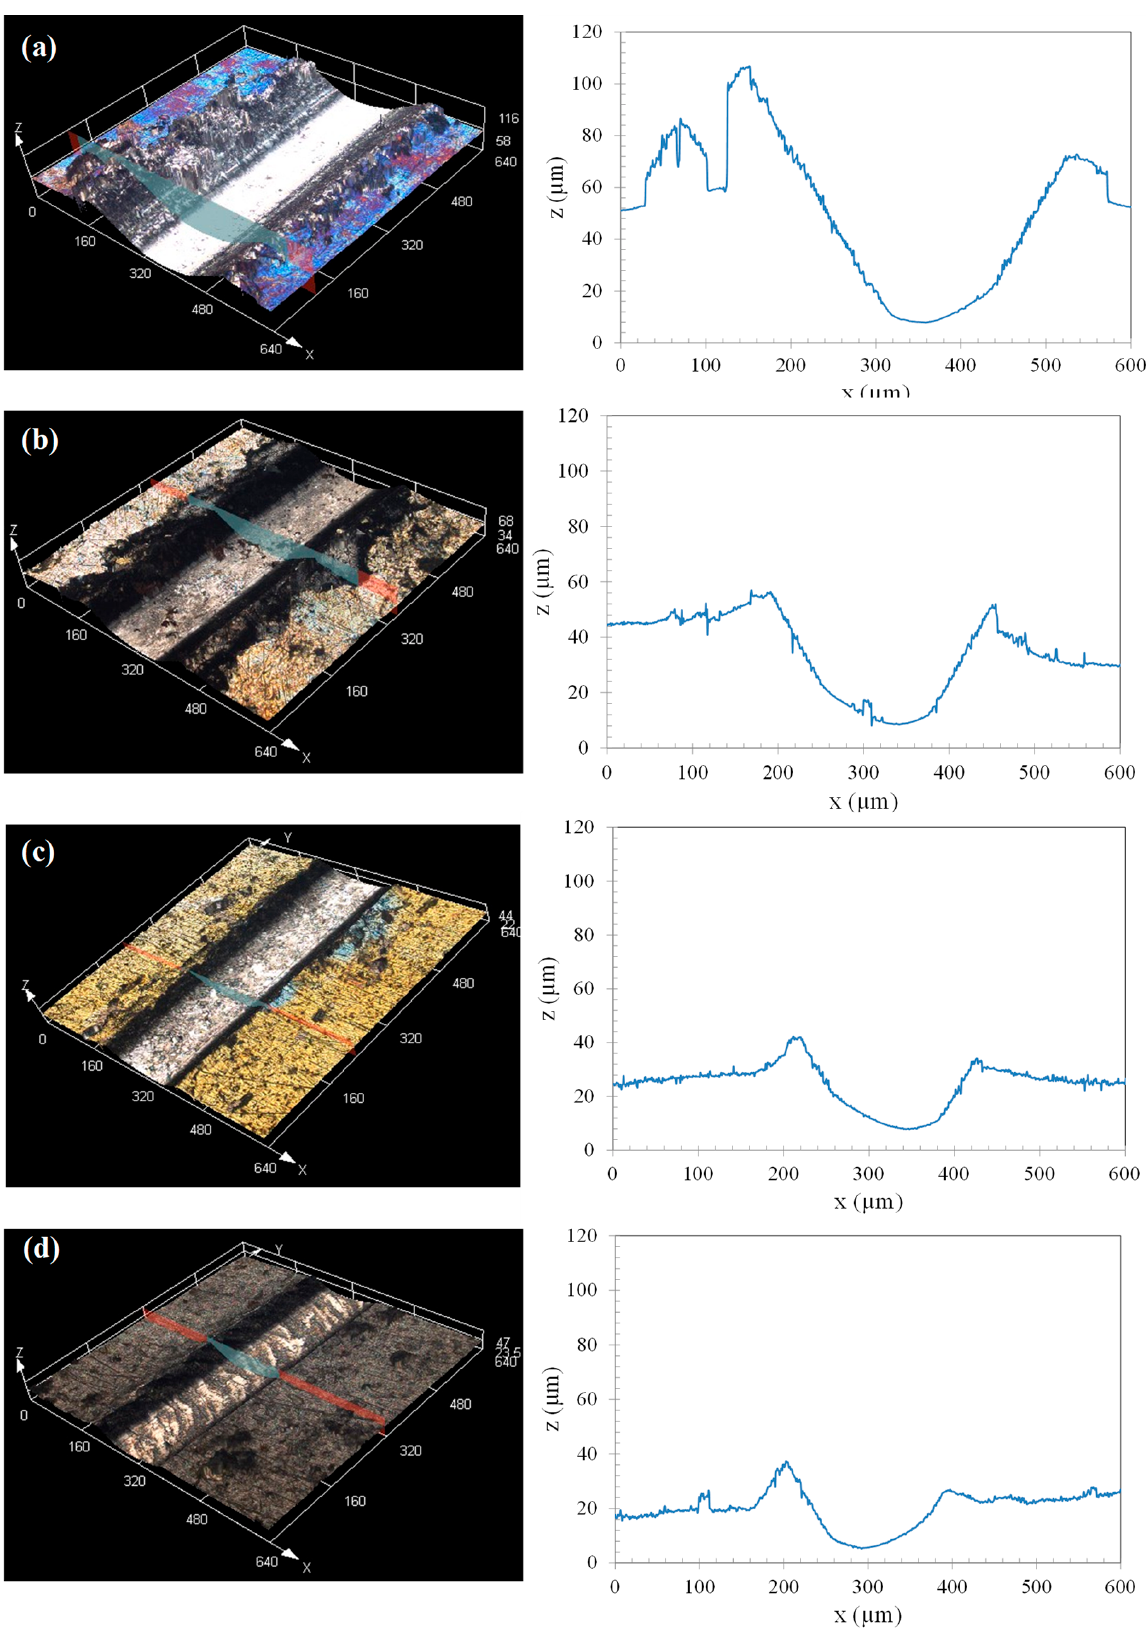
Figure 4. 3D views of the scratched region and the corresponding transverse profile along the lines marked in the micrographs: ( a ) Ni–P; ( b ) CNT-0.25; ( c ) CNT-0.5; ( d ) CNT-1.0.